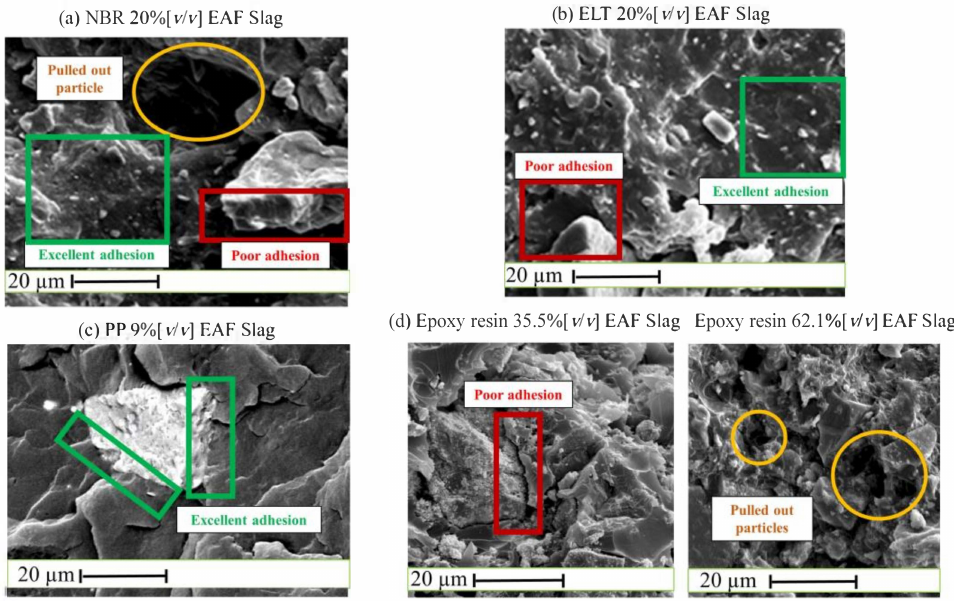
Figure 9. SEM micrograph of cross sections of specimens broken in liquid nitrogen. ( a ) NBR filled with EAF slag 20% ( v / v ). ( b ) ELT filled with EAF slag 20% ( v / v ). ( c ) PP filled with EAF slag 9% ( v / v ). ( d ) Epoxy resin filled with EAF slag 35.5% ( v / v ). and 62.1% ( v / v